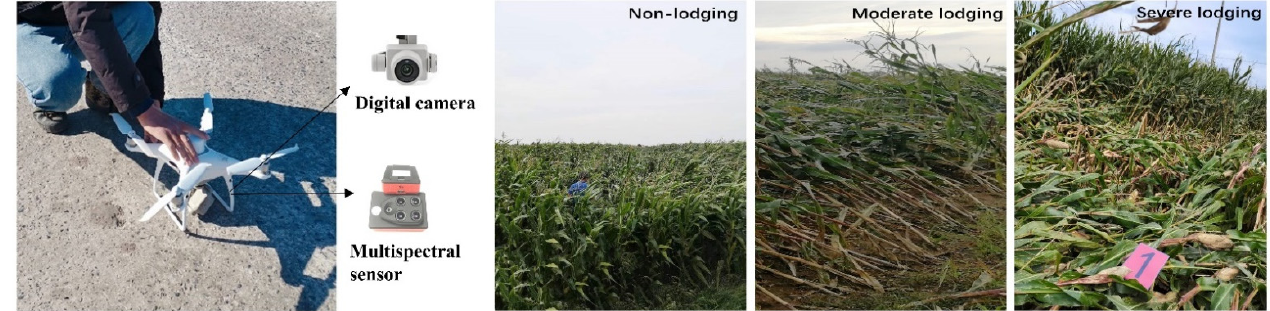
Figure 3. Maize lodging data collection ( left ), aerial imagery collection; (right) , classification of three lodging extents based on crop lodging angle.